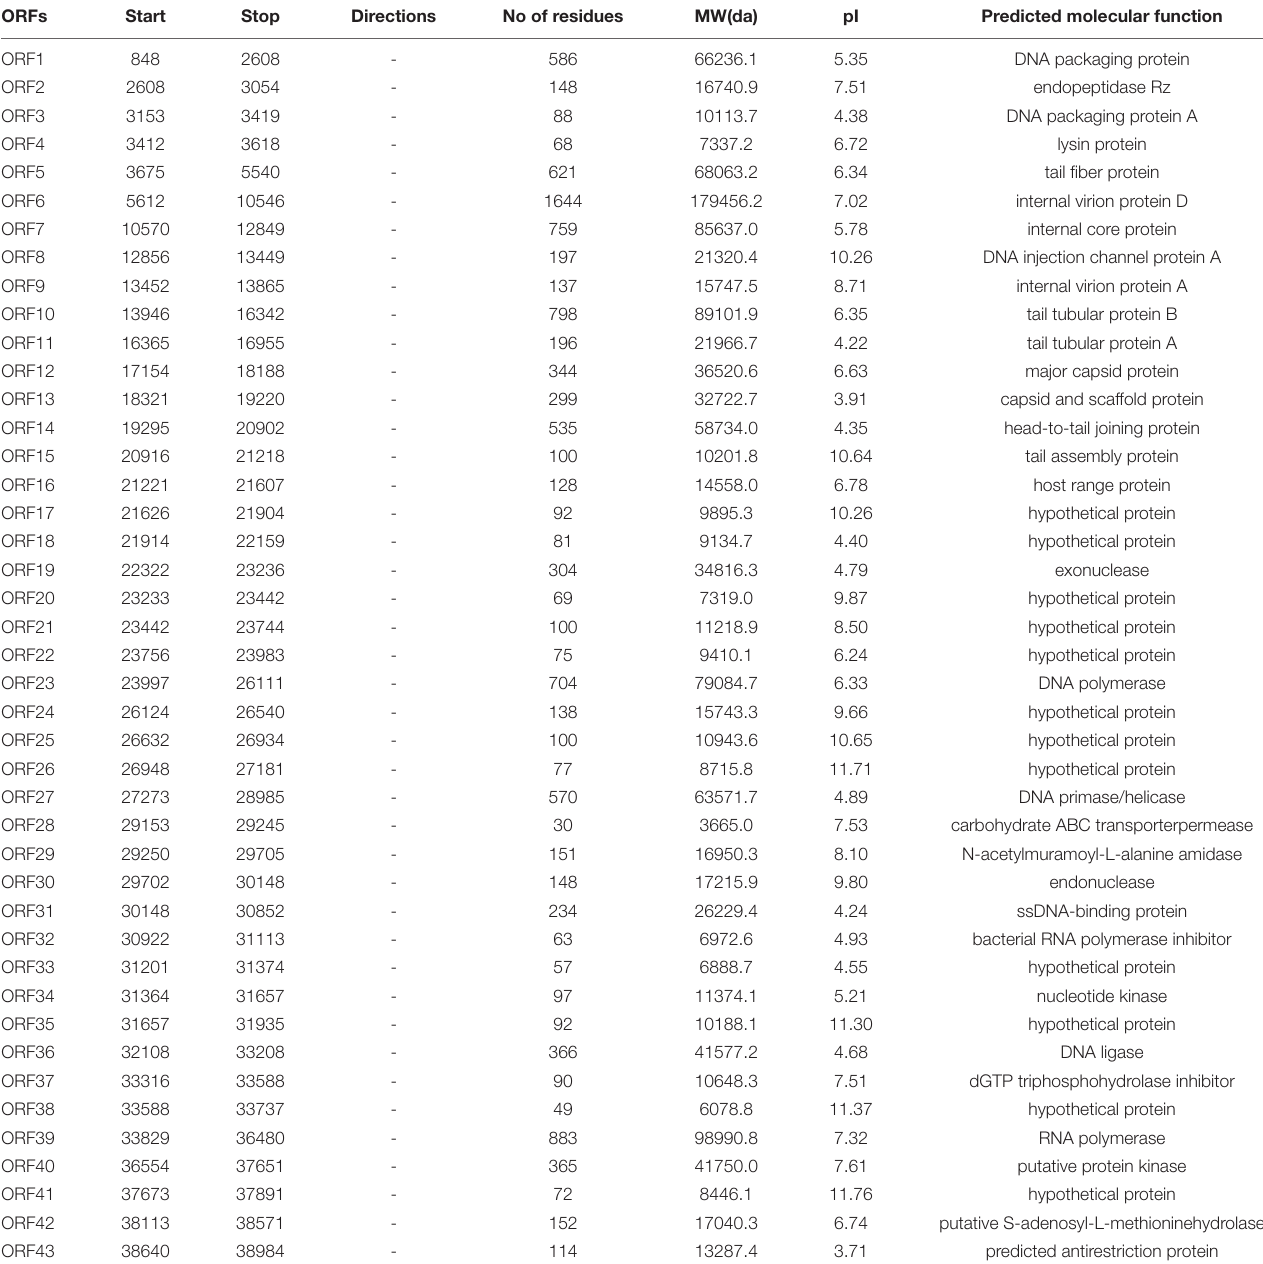
TABLE 2 | Predicted ORFs and genes encoded by the vB_ShiP-A7 genome (GenBank database under accession number MK685668).